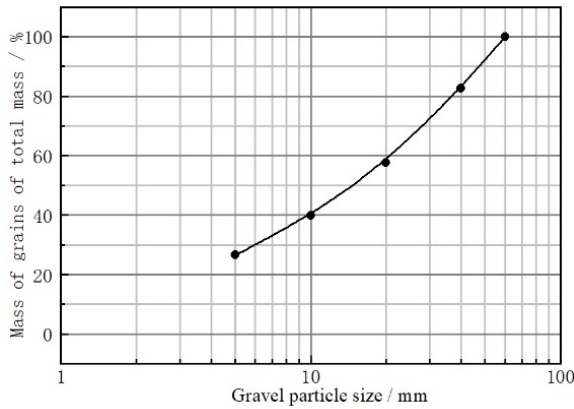
Figure 2. Particle Size Distribution (PSD) curves of test specimens. Table 1. Basic property of tested soil and specimens.